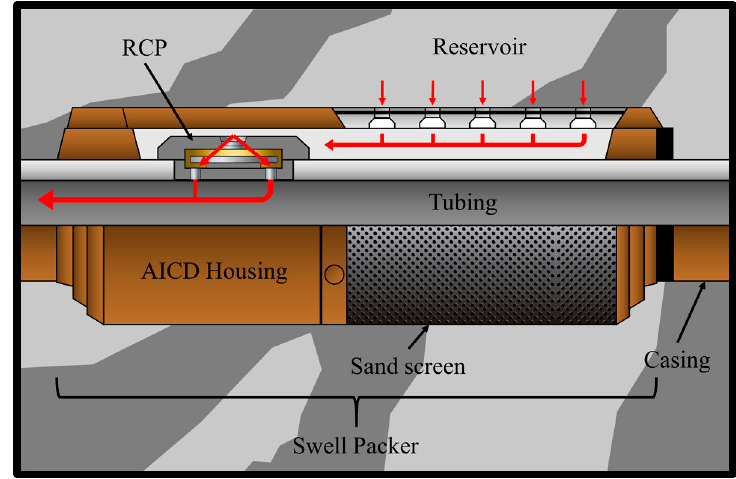
Figure 4. Installation of an RCP in the casing of a horizontal well.